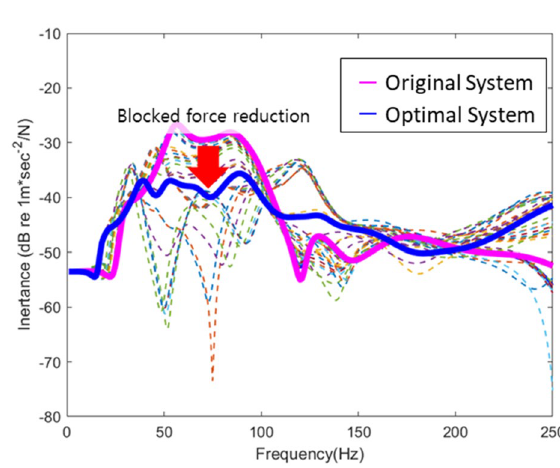
Figure 16. Improvement of the response of the simplified